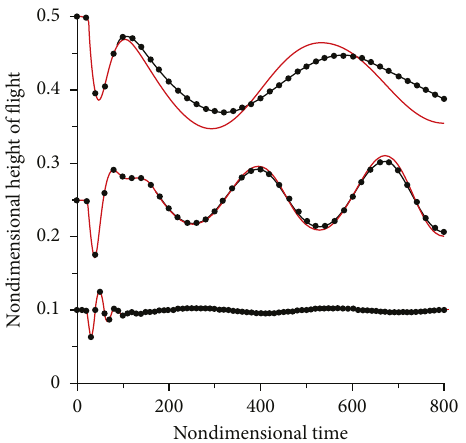
Figure 10: Trajectory of the schematic WIG craft under step-like wind perturbations. Black lines with circles correspond to the simulation with quasi-steady determination of forces.